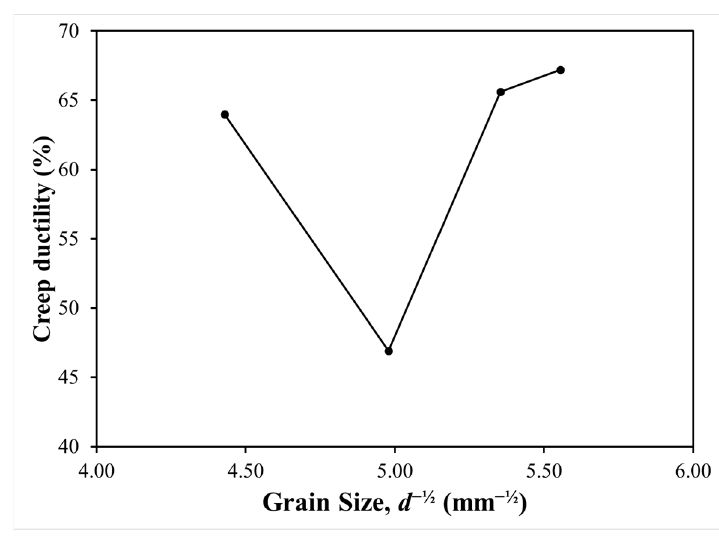
Figure 22. Effect of grain size on creep